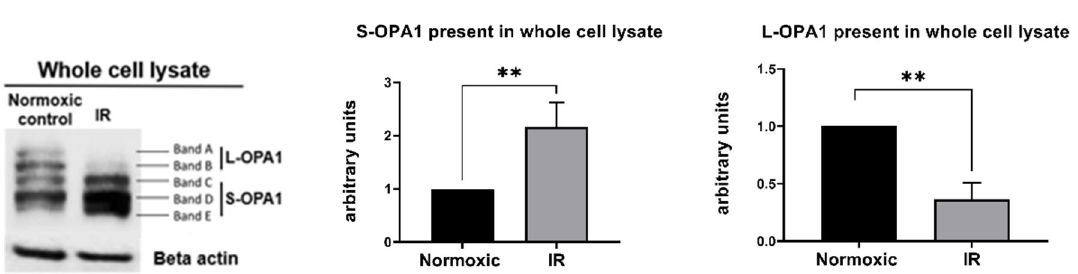
Figure 3. Protocol 2A: Simulated IR increases proteolytic processing of L ‐ OPA1 to S ‐ OPA1, with S ‐ OPA1 redistribution to the cytosol. Original immunoblots ( left panel ) and quantified fold ‐ changes ( right panels ) in OPA1 expression for HL ‐ 1 cells subjected to 2.5 h simulated I + 30 min R. Simulated IR was associated with the formation of S ‐ OPA1 and the loss of L ‐ OPA1 content in whole cell lysates ( ** p < 0.01 versus time ‐ matched normoxic group). n = 5 replicates per group.